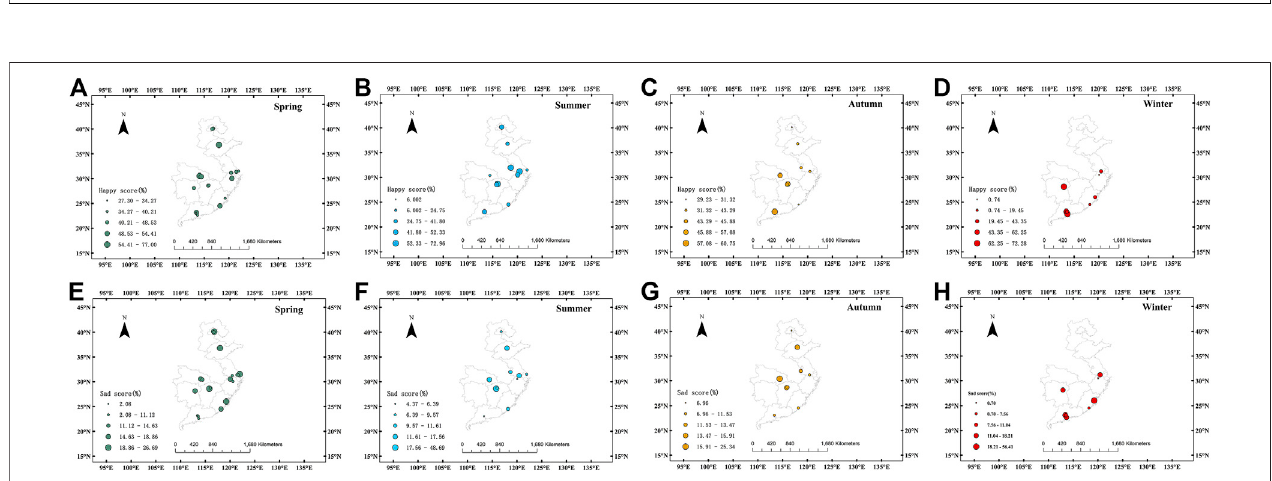
FIGURE 3 | Seasonal geographical distributions of happy (A – D) and sad (E – H) scores of visitors in urban wetland parks at cities of East China. The size of a spot and its adjacent value together remark the average of records when visitors posted their photographs to Sina Weibo at the aimed places.